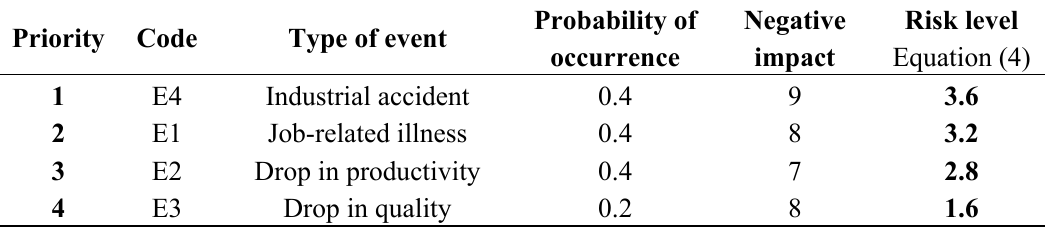
Table 7. Prioritization of identified potential